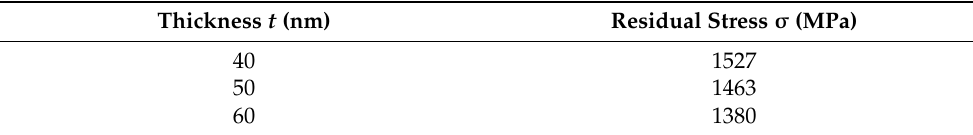
Table 3. Relation between Cr membrane thickness and stress